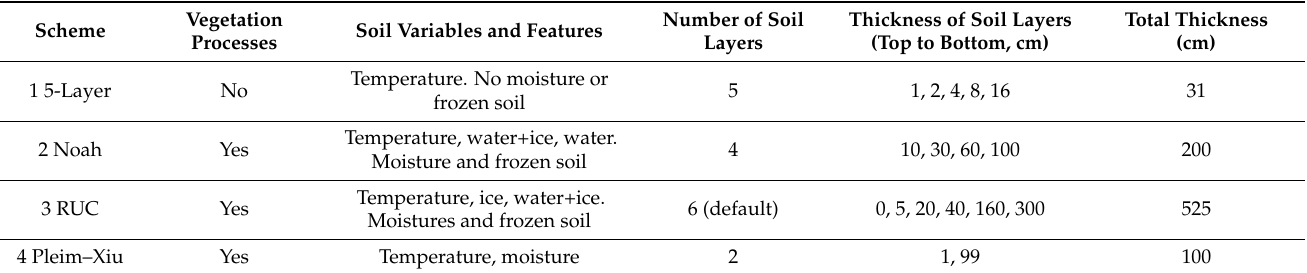
Table 1. Land surface scheme options in the WRF-Chem V3.2, based on [9].